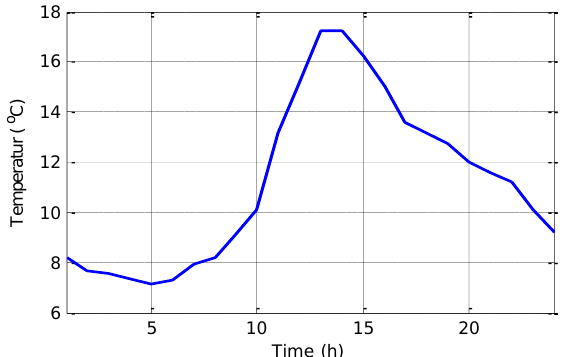
Figure 7. The 24 h solar radiation profile of the case system.